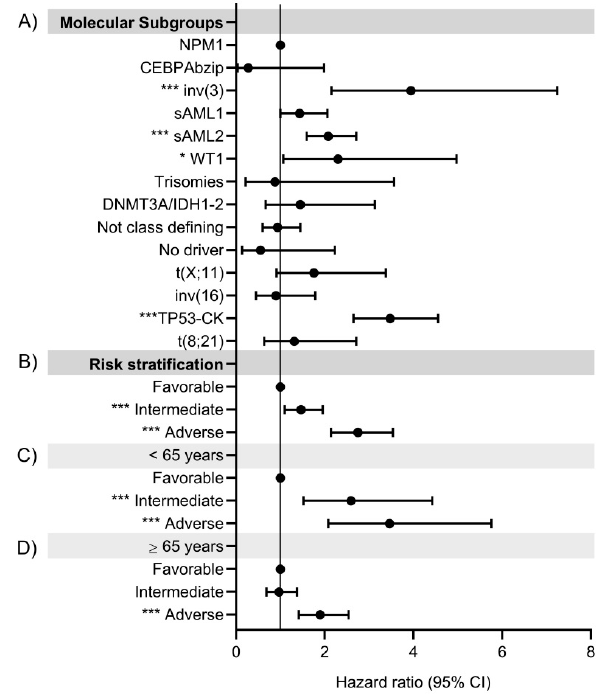
Figure 7. Hazard ratio for death according to ( A ) New molecular subgroups in the global cohort; and new genomic risk score for: ( B ) Global cohort, ( C ) Patients < 65 years and ( D ) Patients ≥ 65 years.* p < 0.05, *** p < 0.001. * p < 0.05, *** p <